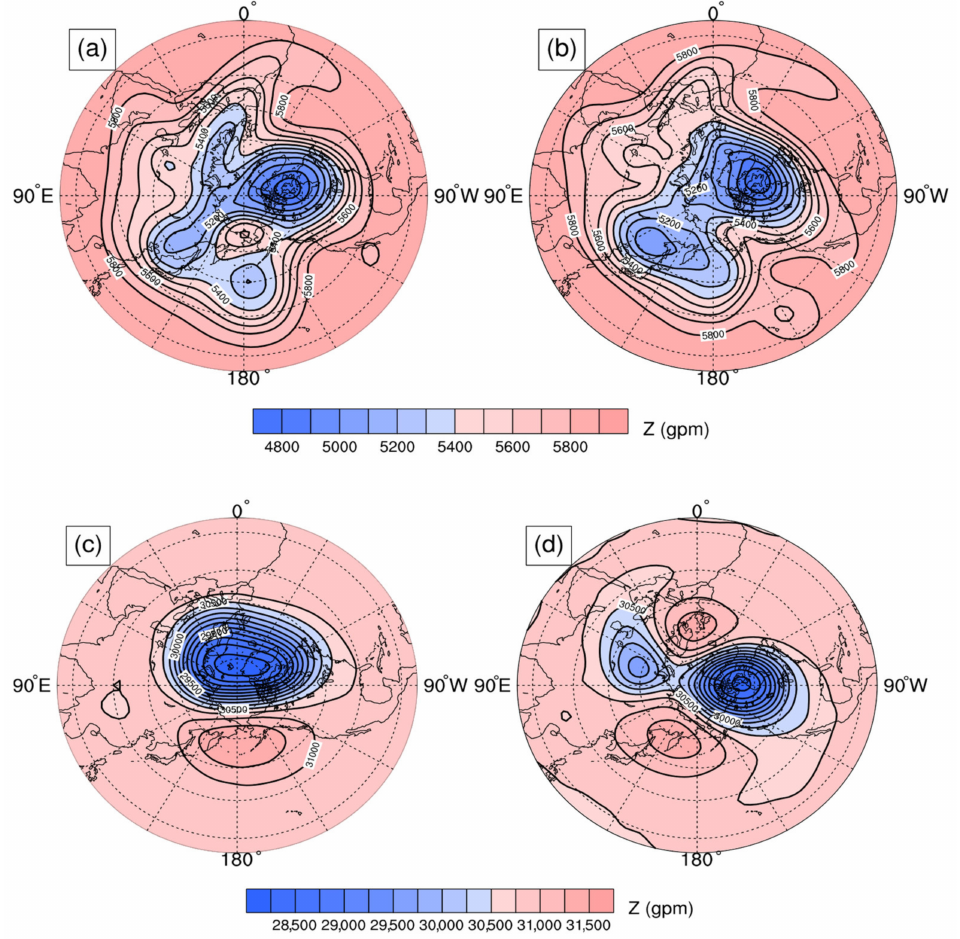
Figure 2. ( a , b ) Synoptic charts of geopotential height (unit: gpm) at 500 hPa averaged from 2 February to 4 February and from 9 February to 11 February; ( c , d ) same as in ( a , b ), but for synoptic charts of geopotential height at 10